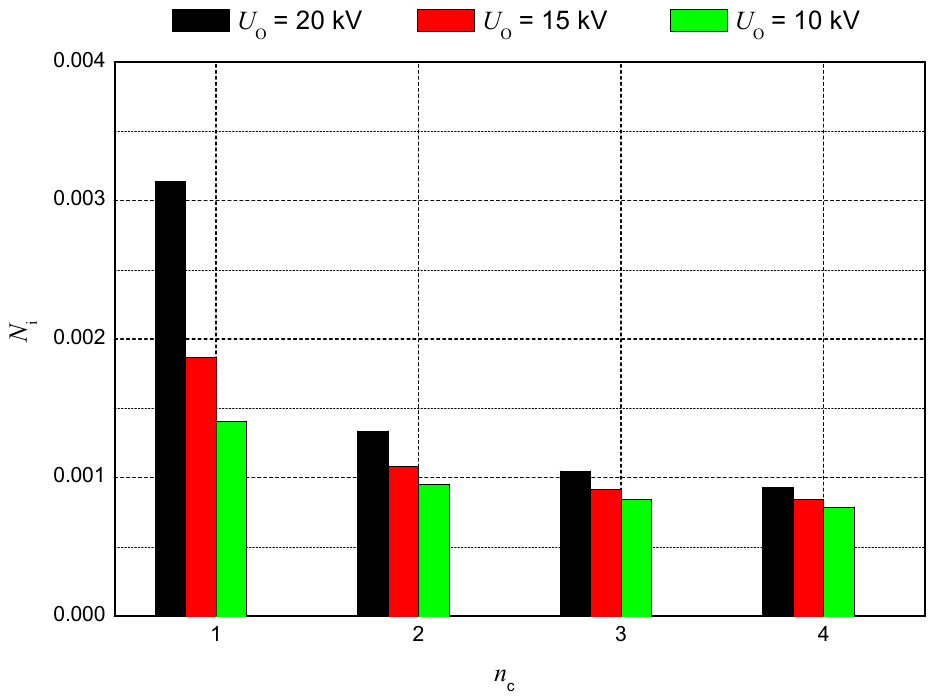
Figure 11. Frequency of damage N I to apparatus as a function of the number n c of connected LV circuits in conduit.